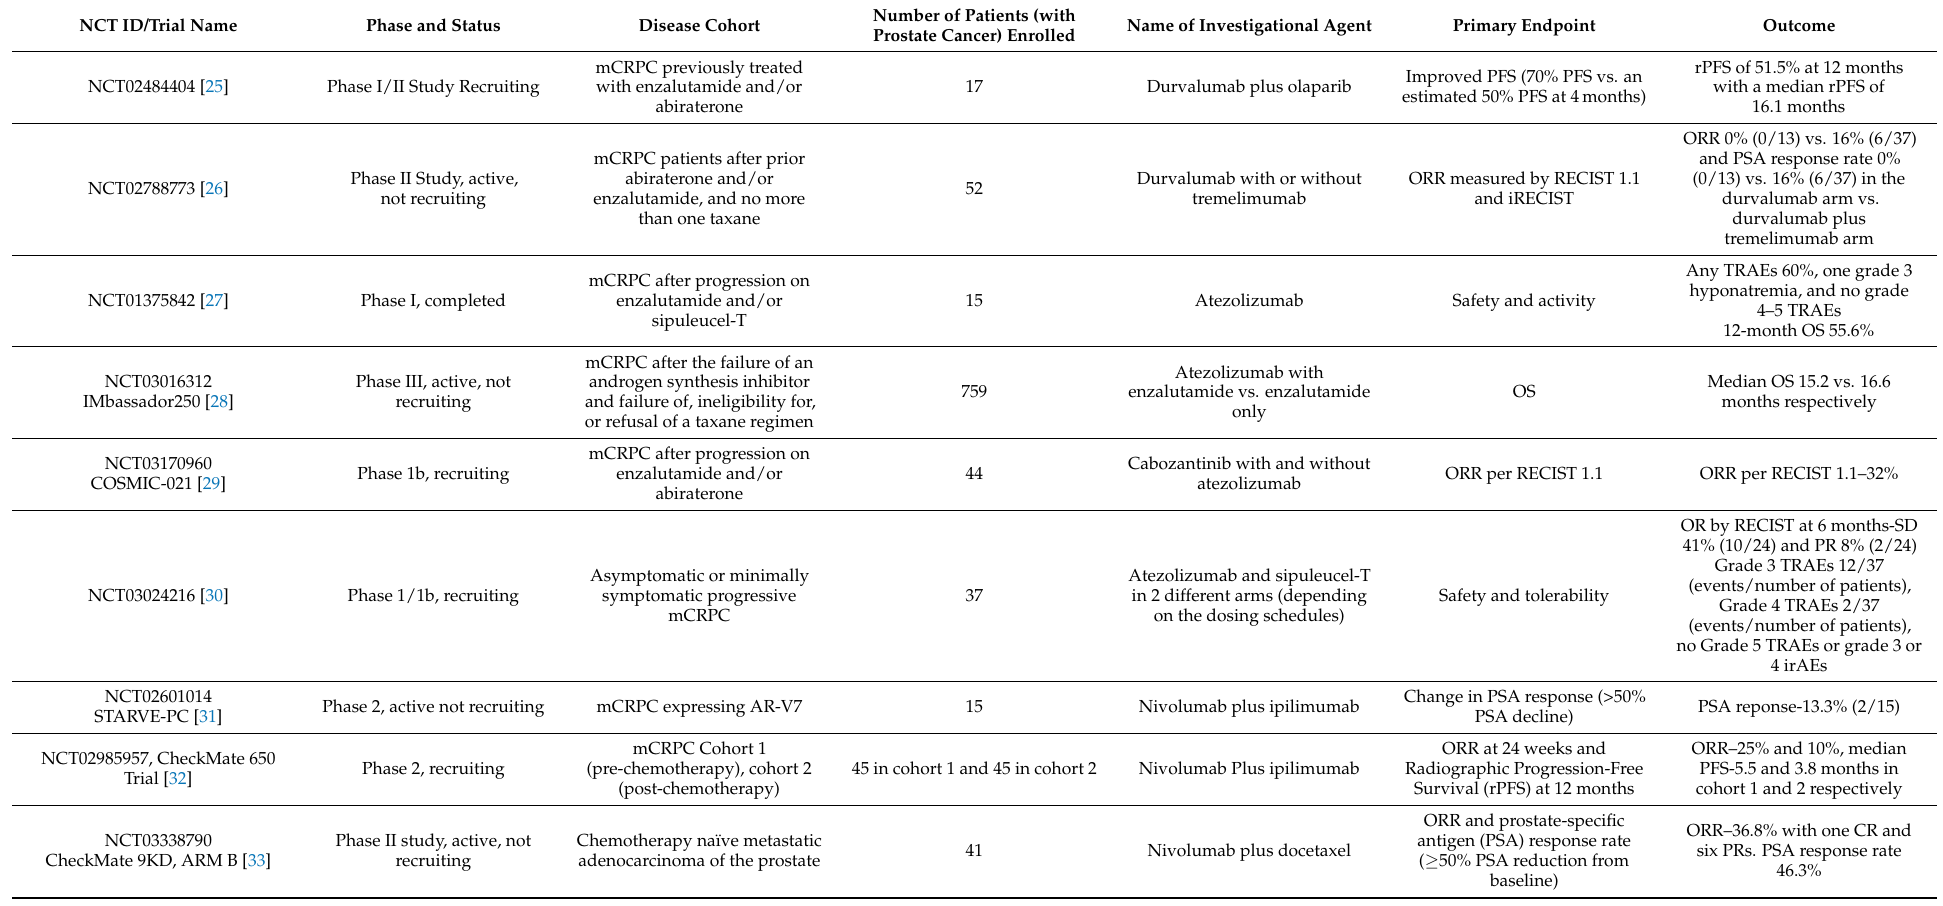
Table 2. Summary of resulted immune checkpoint blockade trials in prostate